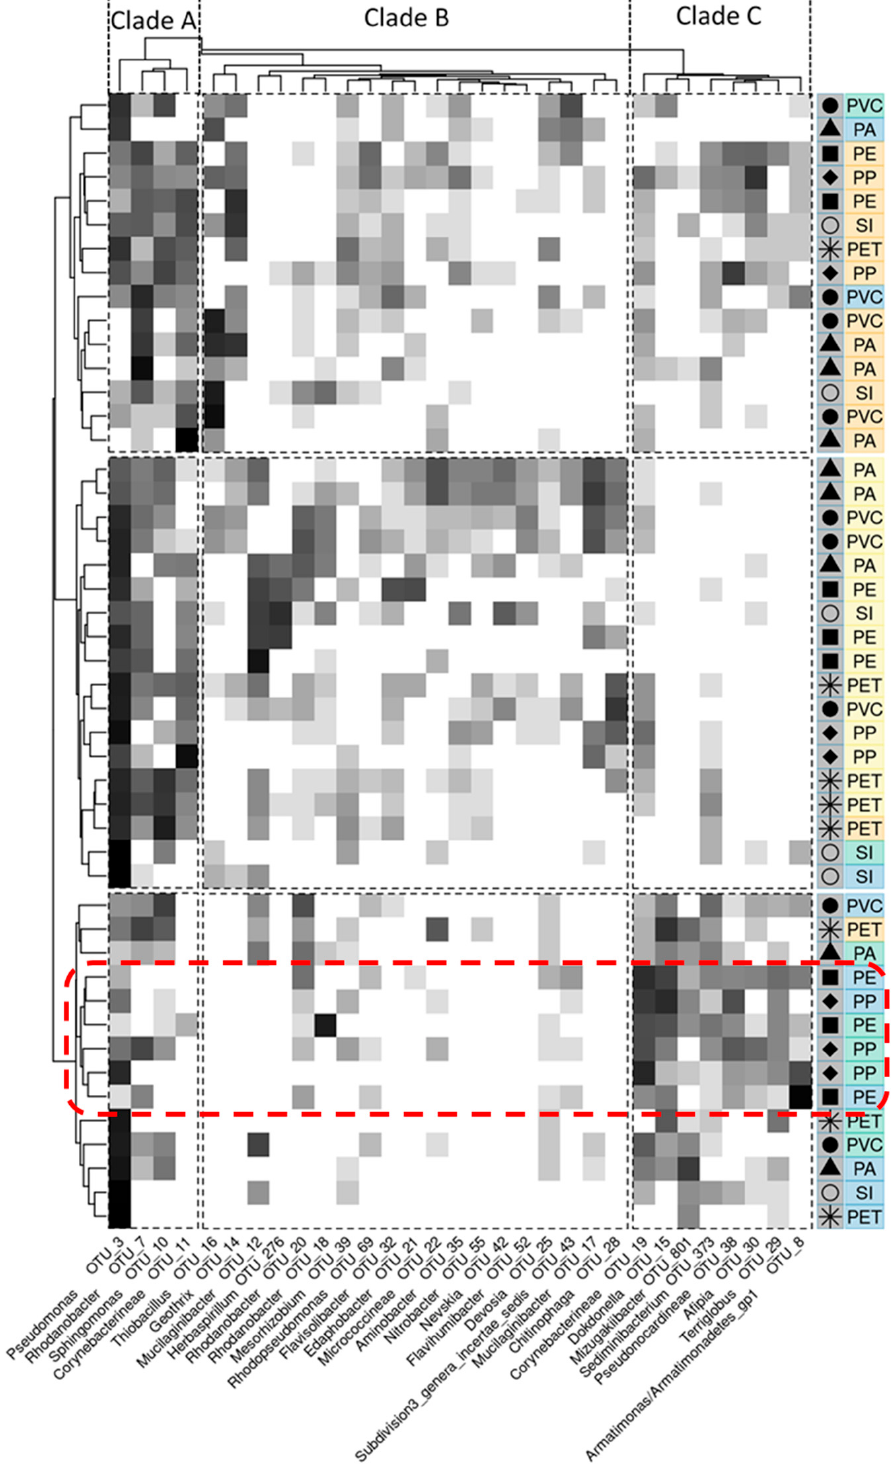
Figure 2. Heatmap based on log-transformed microbial abundances. Colors and icons refer to exposure time and substrate type, as shown in Figure 1. Groups of samples and clades of OTUs are demarked by black dashed lines and defined based on k-means clustering of the euclidean distance between samples. Dendrograms represent euclidean distance clustered via complete linkage. Red box refers to a possible sub-group of > 6-month polyolefins. PA: polyamide; PE: polyethylene; PET: polyethylene terephthalate; PP: polypropylene; PVC: polyvinyl chloride; SI: silica (control).